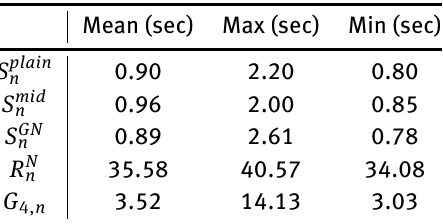
Table 1: Running Times of S plain